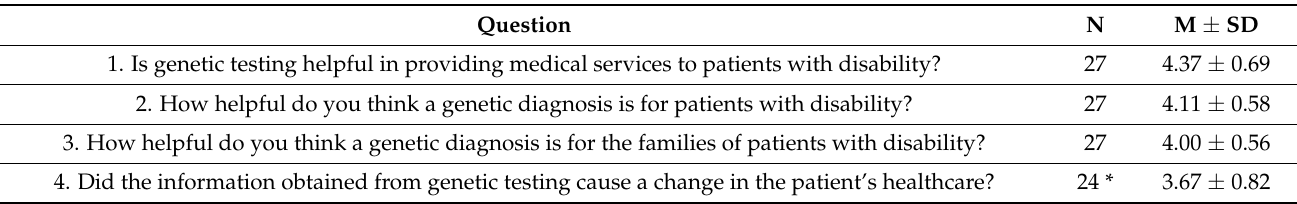
Table 3. Usefulness of genetic